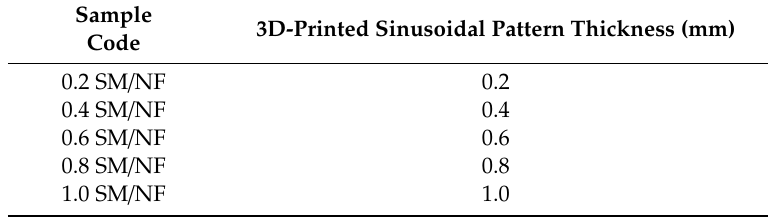
Figure 2. Heating-cooling process of 3D-printed sinusoidal sample/nylon composite with various thicknesses and various cycles. Table 1. Sample code of 3D-printed sinusoidal sample/nylon composite with various thicknesses.